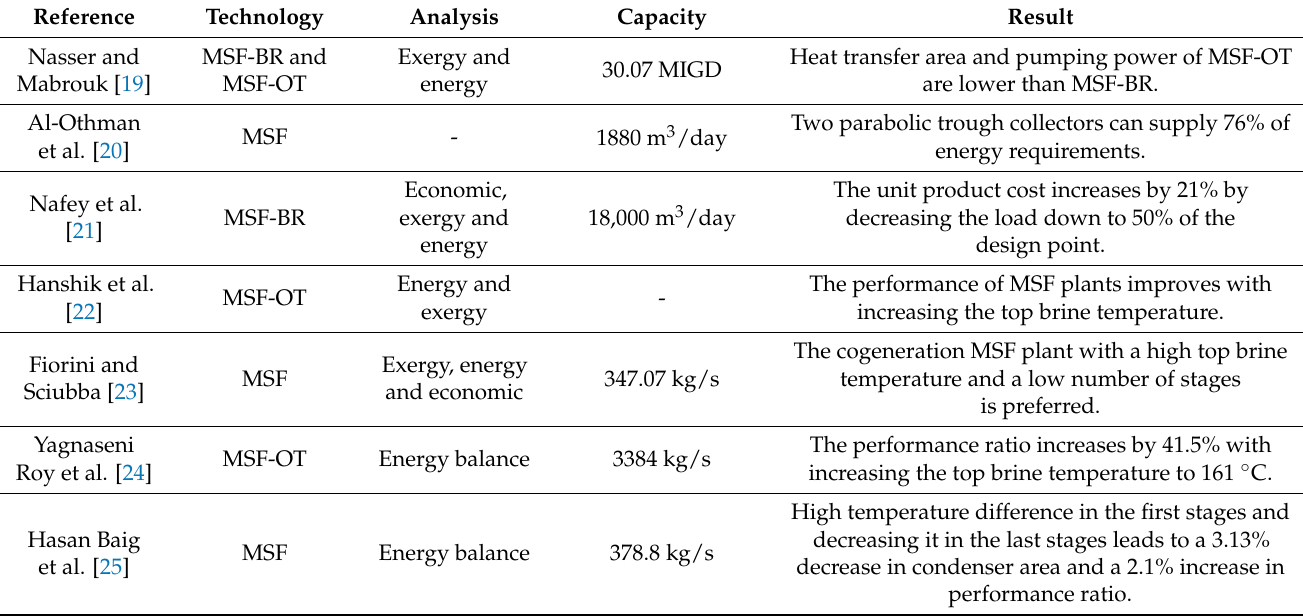
Table 1. Summary of studies conducted on MSF